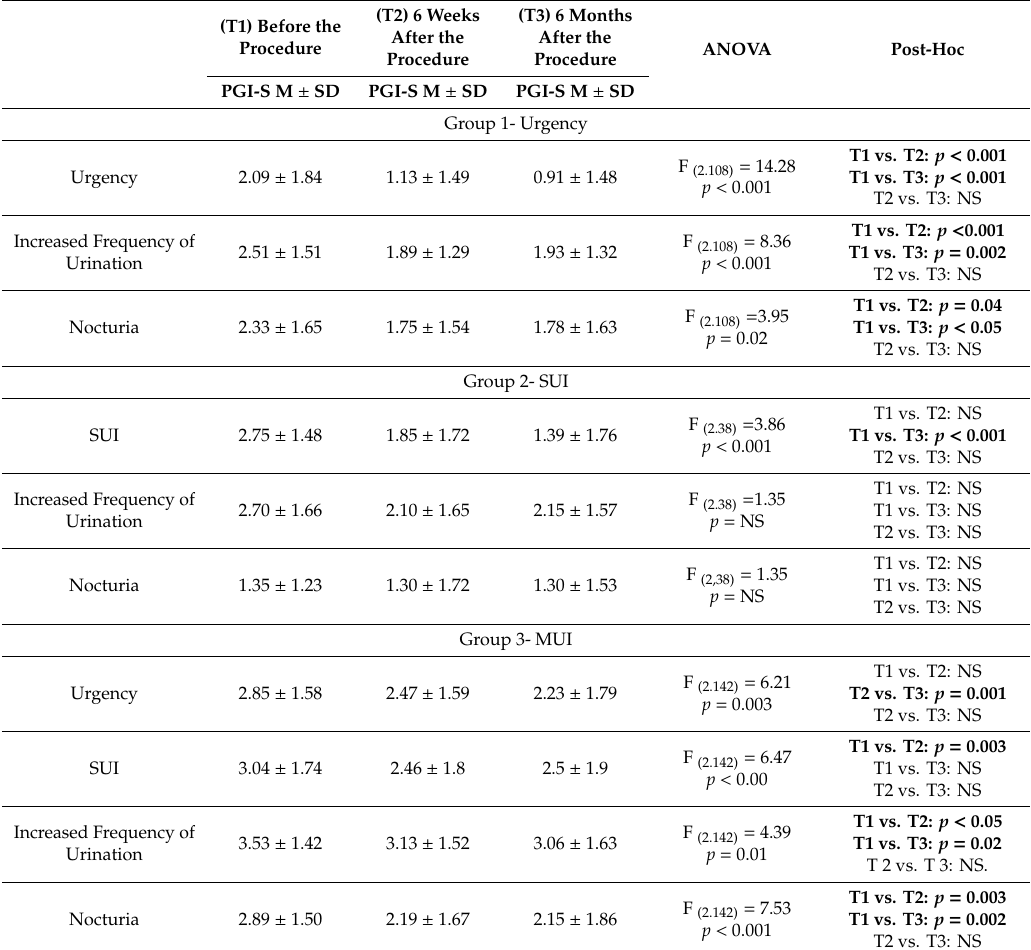
Table 2. The evolution of storage lower urinary tract symptoms (LUTS) after vaginal native tissue repair (VNTR) in studied